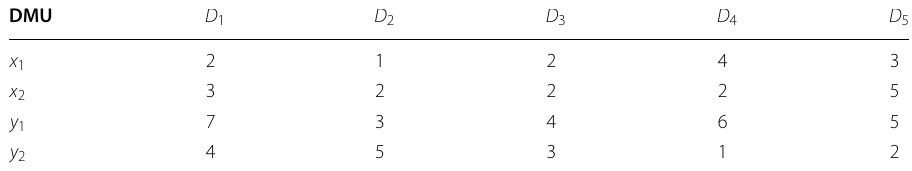
Table 2 Example 2: Multiple input and output